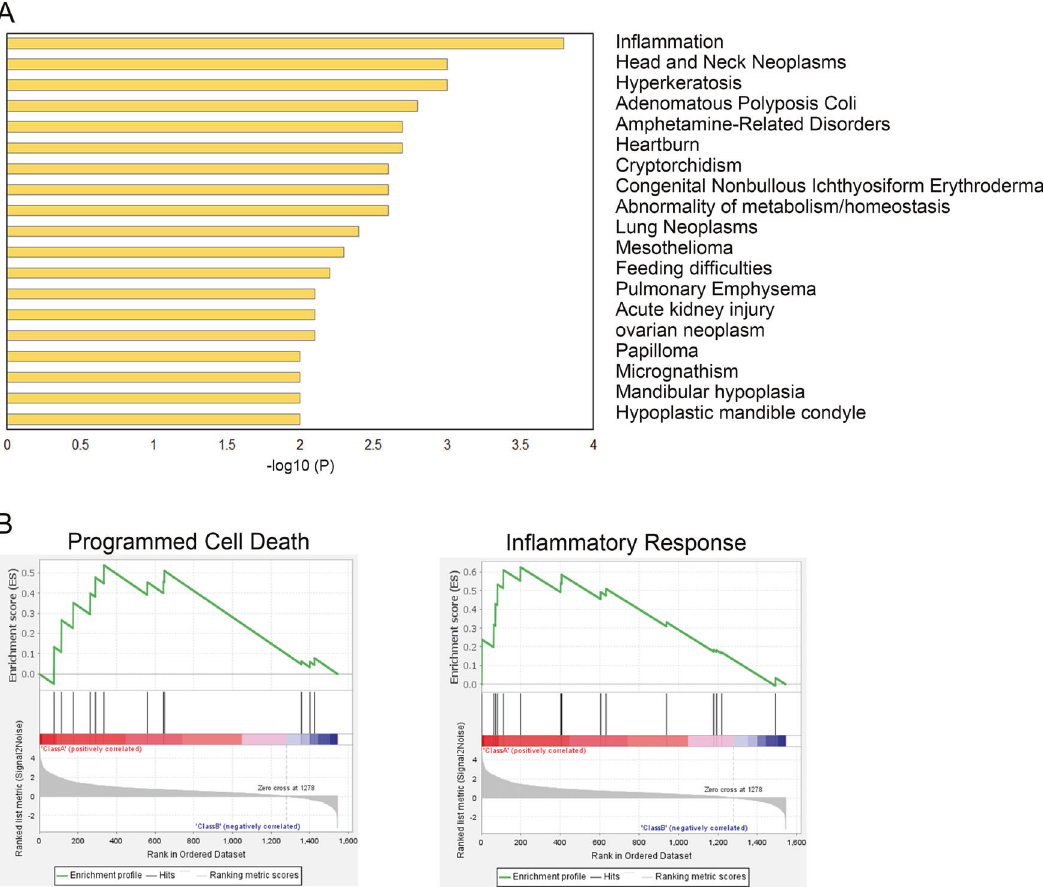
Fig. 5 RBM15 contributes to the severity of COVID-19. A DisGeNET analysis for Hyper-Up genes speci fi cally present in the severe group. B Gene set enrichment analysis (GSEA) was performed using Hyper-Up genes (531) in group S, but not in group M. GSEA was used using the Molecular Signatures Database (MSigDB) of Hallmarks gene sets (h.all.v7.1.symbols), Canonical pathways gene sets (c2.cp.v7.1.symbols) and GO biological process gene sets